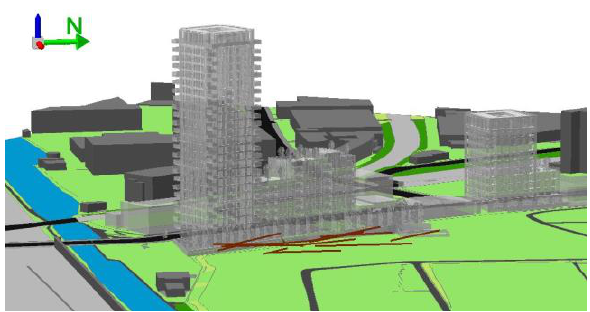
Figure 4 The zoomed in bats' flight paths model.